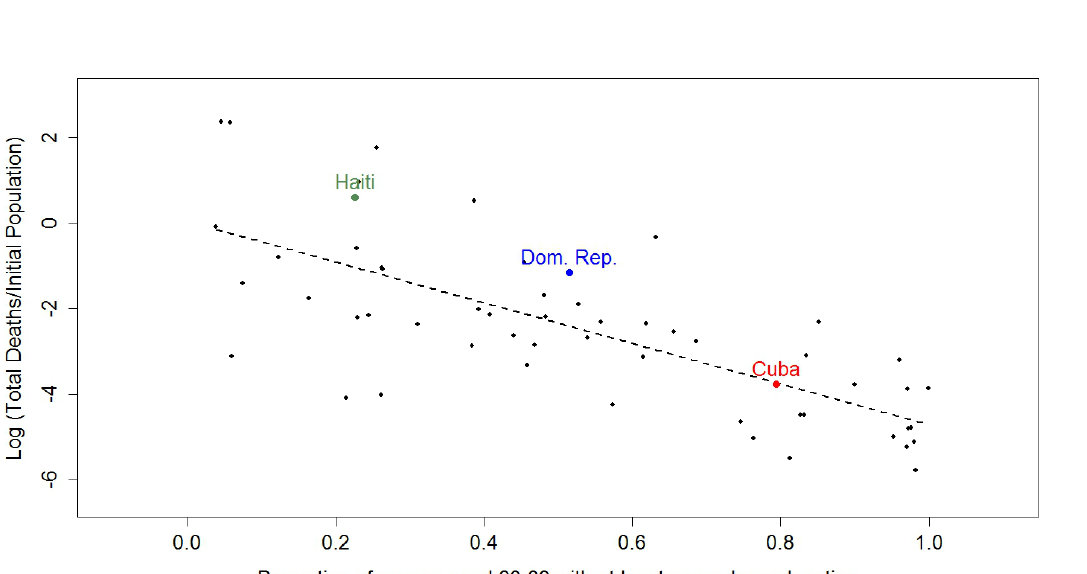
Fig. 2 . Relationship between the log of deaths from climatic natural disasters including floods, droughts, and storms per 1000 of the 1980 population (CRED 2004) and female education, proportional to secondary and higher education among women aged 20-39 (Lutz et al. 2007), for 56 countries with one or more disasters on average per